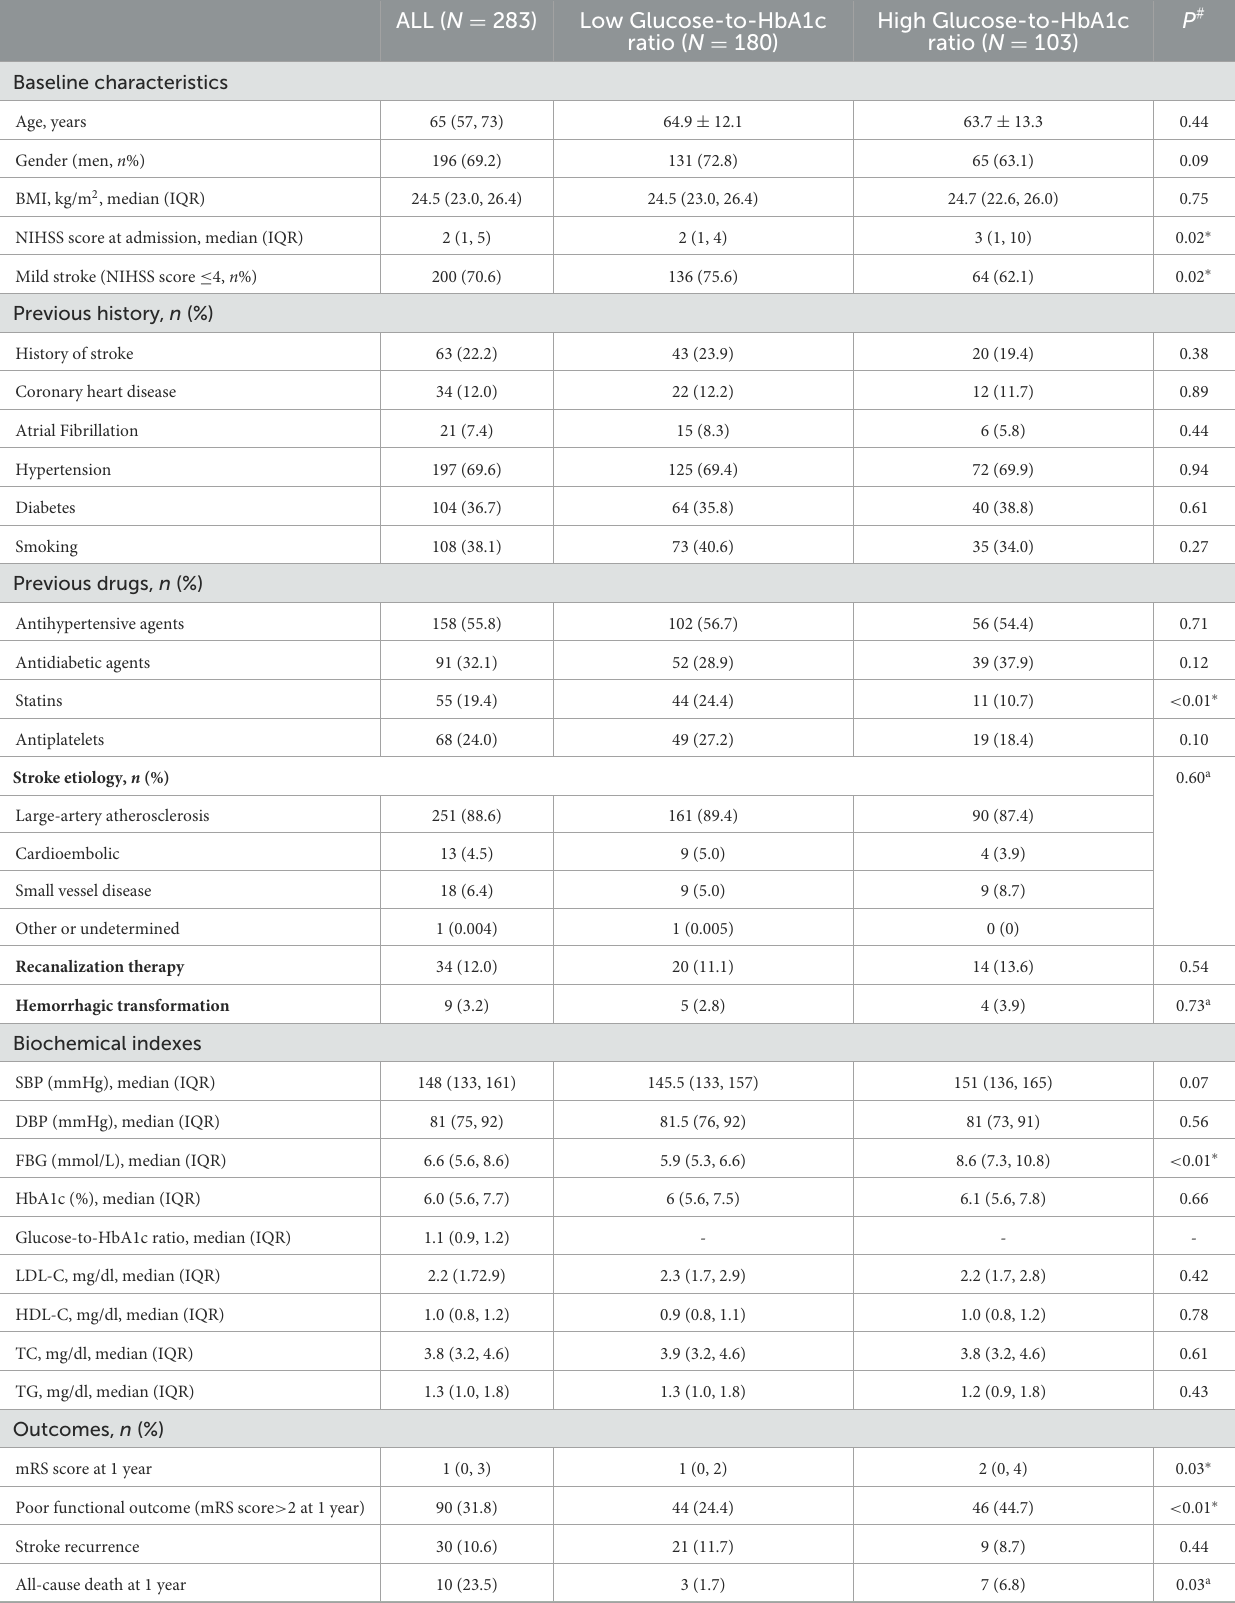
TABLE 1 Comparison of low-stress hyperglycemia ratio (glucose-to-HbA1c ratio < 1.135) vs. high-stress hyperglycemia ratio (glucose-to-HbA1c ≥ 1.135) in patients with acute ischemic stroke.